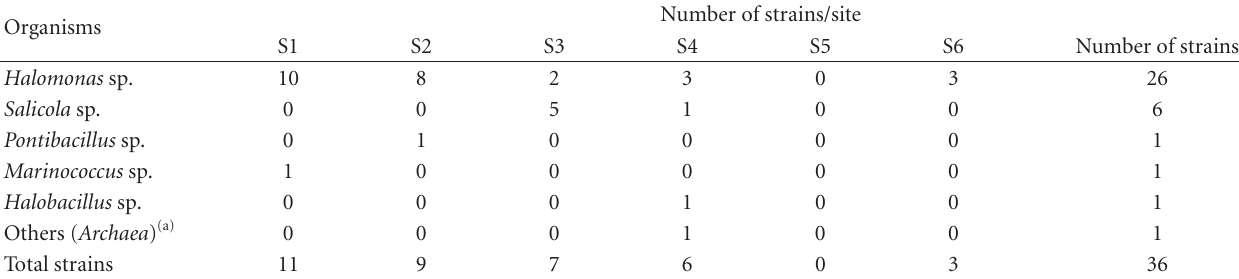
Table 2: Distribution and taxonomic characteristics of bacteria and archaea isolated from the 6 sampling sites in El-Djerid Lake. Number of strains/site Organisms S1 S2 S3 S4 S5 S6 Number of strains Halomonas sp. 10 8 2 3 0 3 Salicola sp. 0 0 5 1 0 0 Pontibacillus sp. 0 1 0 0 0 0 Marinococcus sp. 1 0 0 0 0 0 1 Halobacillus sp. 0 0 0 1 0 0 1 Others ( Archaea ) (a) 0 0 0 1 0 0 Total strains 11 9 7 6